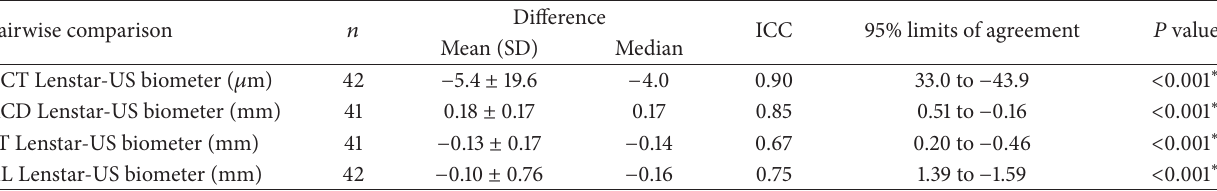
Table 2: Pairwise comparison of axial length, anterior chamber depth, lens thickness, and central corneal thickness in keratoconic eyes using the Lenstar and USG biometry.